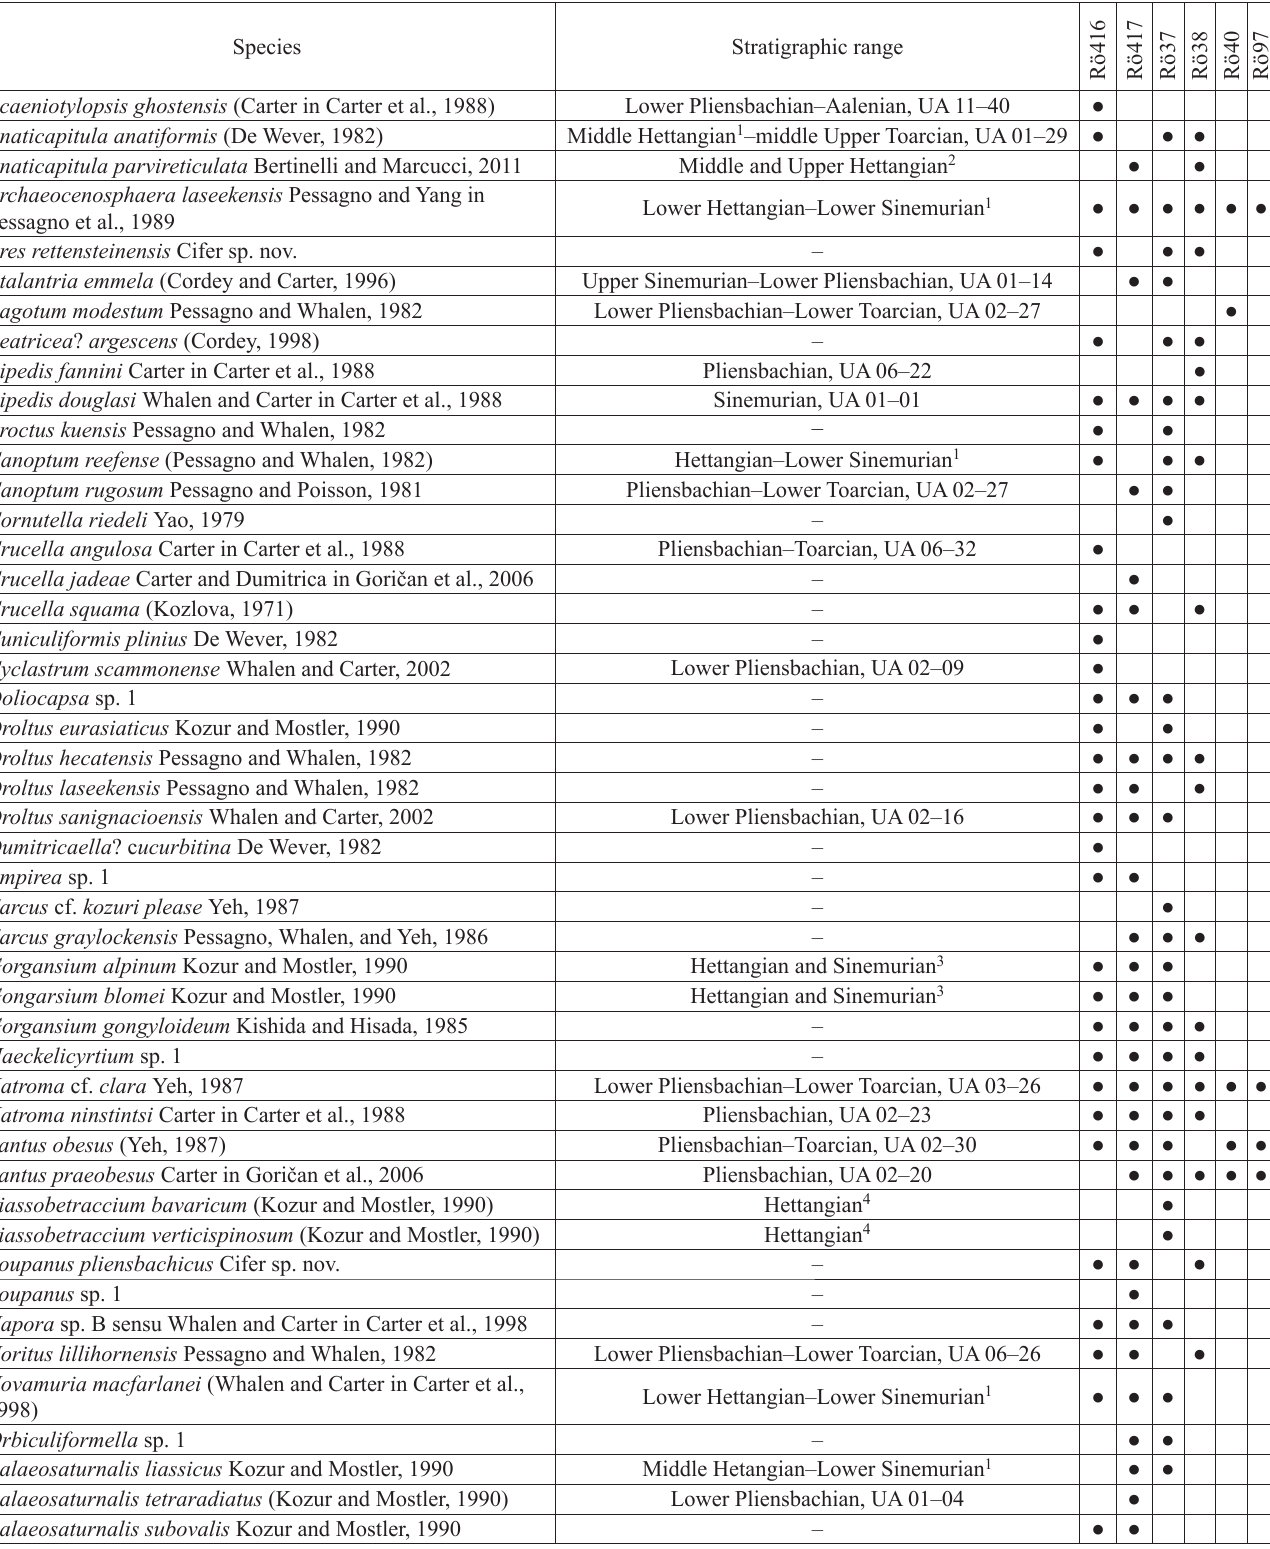
Table 6. Occurrence of species in the samples studied. Stratigraphic ranges are given according to Carter et al. 2010 (UA Uppermost Sinemuri- an–Aalenian), unless otherwise indicated: 1 after Carter et al. 1998; 2 after Bertinelli and Marcucci 2011; 3 Tekin 2002; 4 Kozur and Mostler 1990; 5 Pessagno and Blome 1980; 6 Yeh and Yang 2006. Species with blank ranges are either long ranging or have a sparse record. Sample age: Rö416, Rö417, Rö37, Rö38, Canutus tipperi – Katroma clara (UA 02–05) to Zartus mostleri – Pseudoristola megaglobosa (UA 06–09); Rö40, Rö97, Zartus mostleri – Pseudoristola megaglobosa (UA 06–09) to Eucyrtidiellum nagaiae – Praeparvicingula tlellensis (UA 19–23). Species Stratigraphic range R